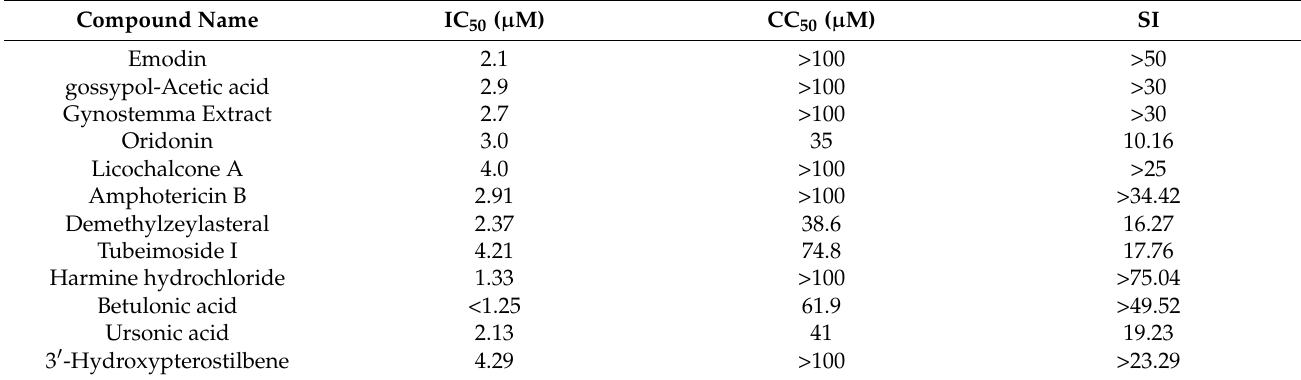
Figure 4. HTS for inhibitors of PEDV infection from a natural products library. ( A ) HTS assay flowchart. The 63 primary candidates were identified using criteria of an average >90% inhibition in triplicate wells. In the secondary screening, 25 compounds with dose-dependent inhibition and SI >10 was selected. ( B ) The HTS of a library of 803 natural products for primary candidates against PEDV infection. Each dot represents the percentage inhibition of a compound at a concentration of 10 μ M. Dots in the blue box represents the prime candidates with inhibition >90% and no obvious cytotoxicity. ( C ) Confirmation of anti-PEDV activity by TCID 50 . Vero cells were treated with the hit compounds for 1 h and then inoculated with wild-type PEDV at a MOI of 0.01. At 20 h post-infection, the cell cultures were harvested for TCID 50 assay. Data are presented as means ± SDs from three independent experiments, * p < 0.05.